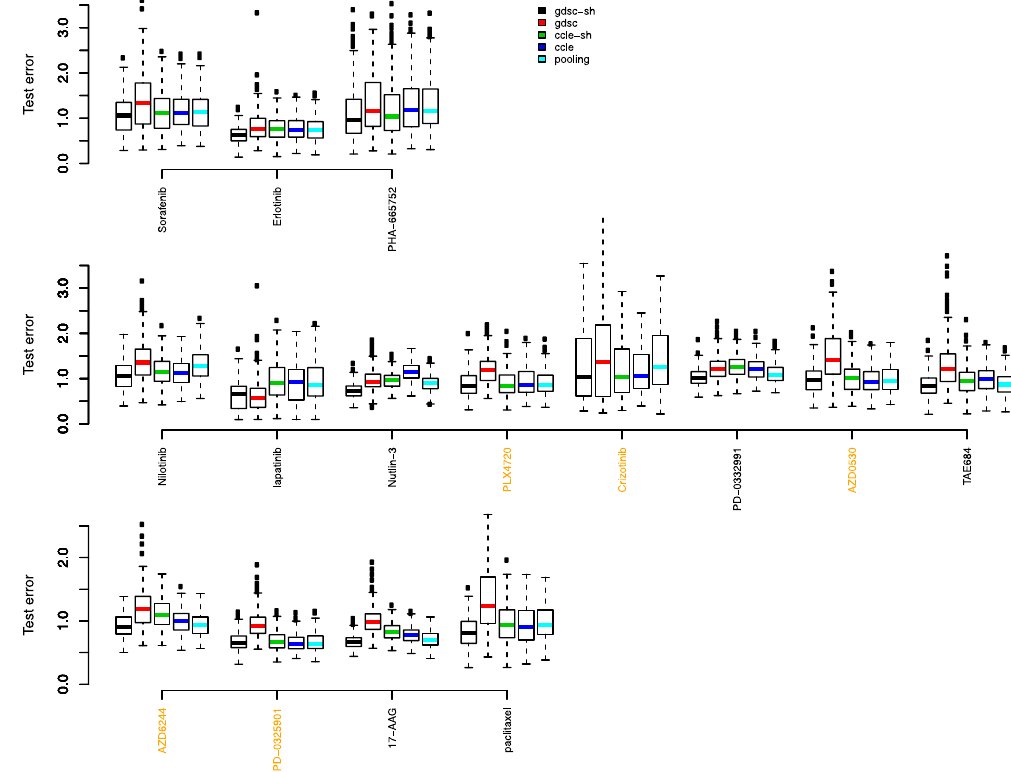
Figure 5. Test error rate boxplots by drug when 70% of 80% GDSC dataset were used in training data and 20% GDSC dataset were reserved as test data. Black represents predictions based on data sharing estimates for β alone; red for predictions from a model using GDSC alone; green for predictions from a data sharing model using estimates of β + δ ; blue for predictions from a model using CCLE alone, and light blue, predictions from a pooled GDSC + CCLE